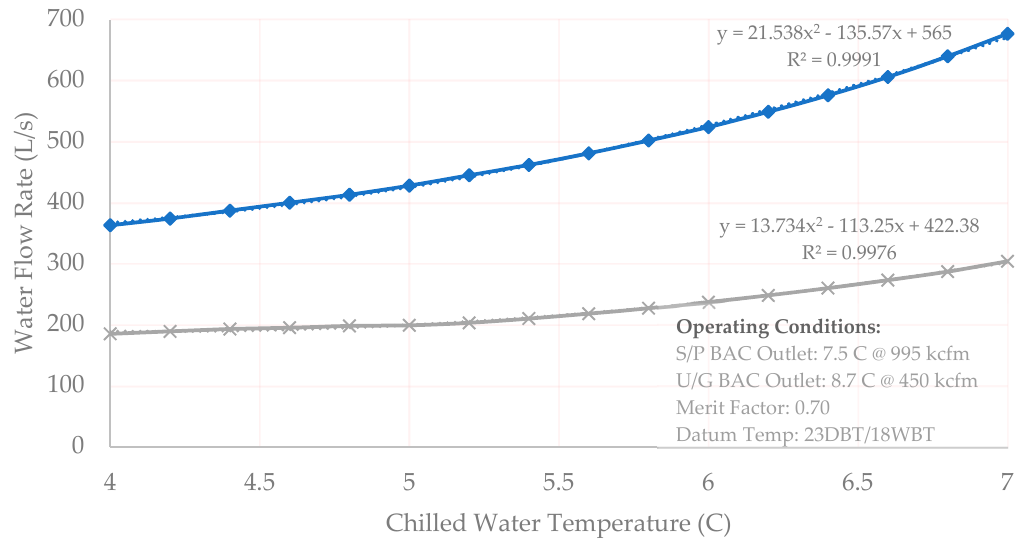
Figure 13. Chilled water temperature versus water flow curves.